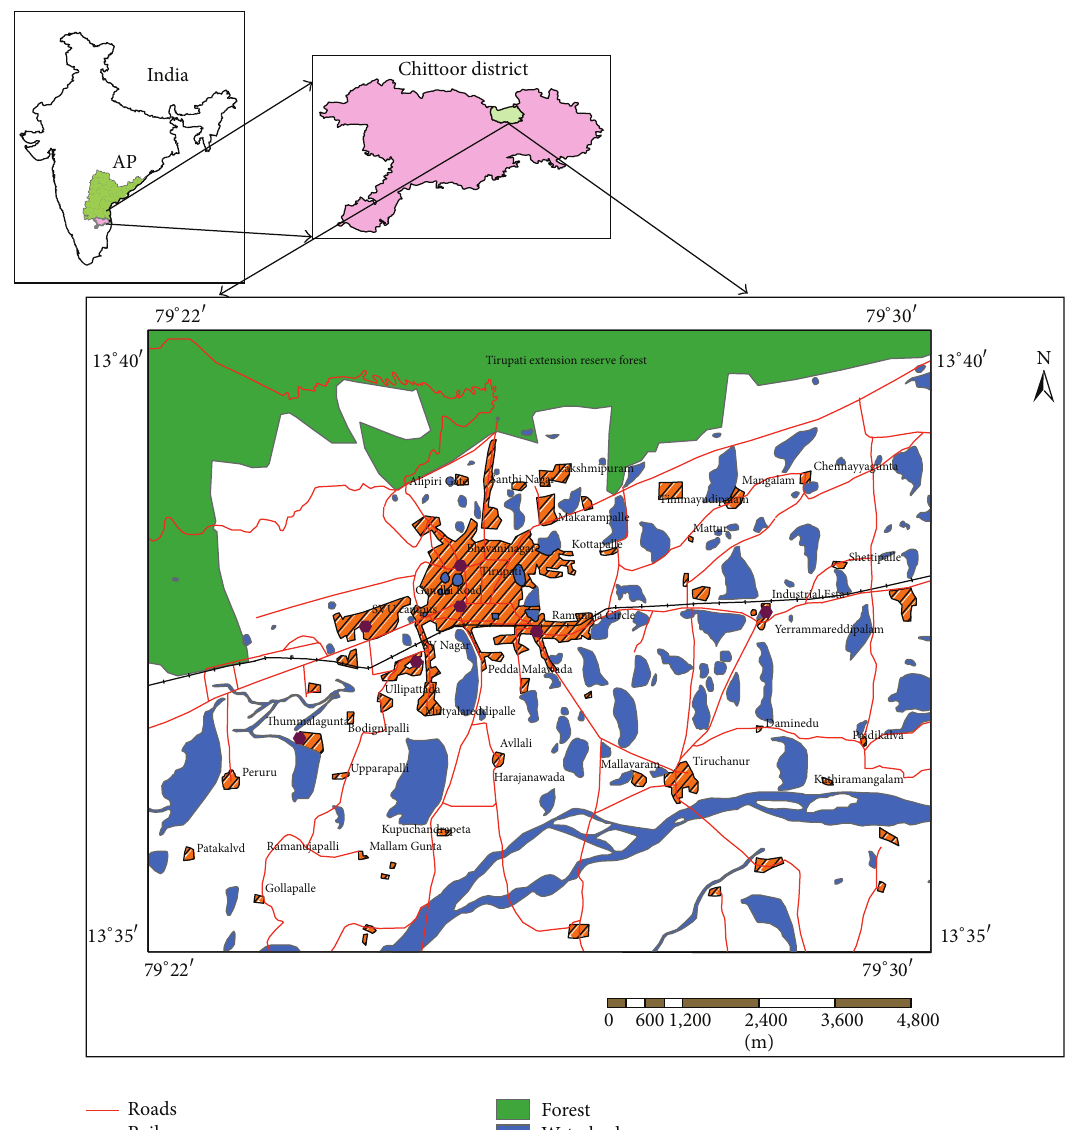
Figure 1: Location of the study area,